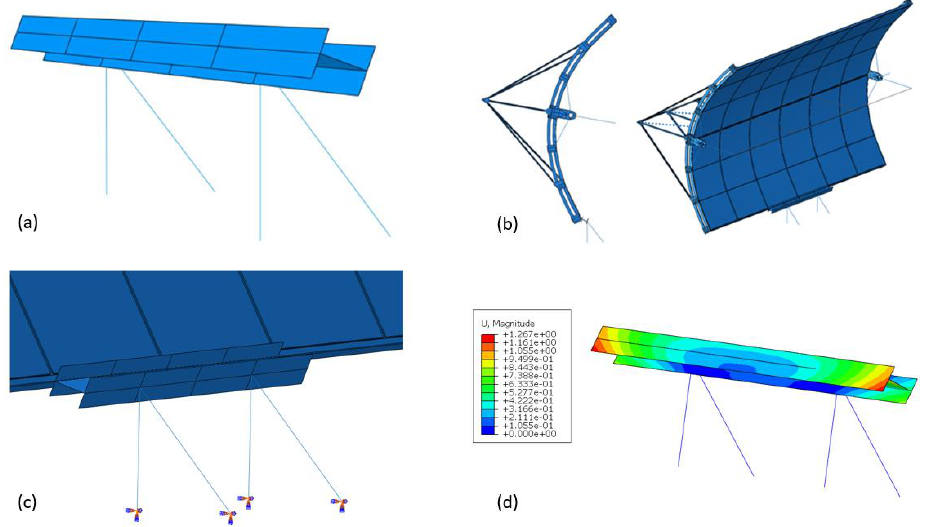
Figure 11. ( a ) Contrast structure, ( b ) distributed bending configuration, ( c ) encastre applied on the contrast structure, ( d ) contours (in mm) of the displacement magnitude of the contrast structure when the maximum load is applied. The constraint scheme adopted for this configuration is reported in Figure 12a. As for the torsion, the rotation has been applied in a midpoint between the constraints related to the bearings but in this case this rotation is applied on both ends of the trough while the rotation has been fixed at one end in the differential torsion.